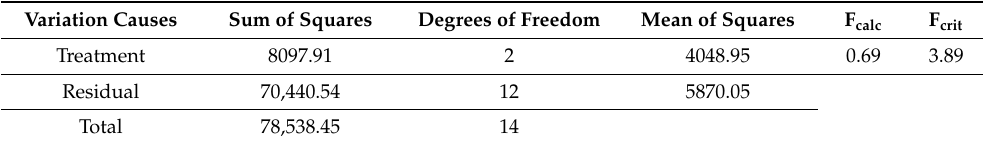
Table 8. ANOVA of E abs from the 7.62 mm stand-alone ballistic tests of arapaima scales composites and plain epoxy.